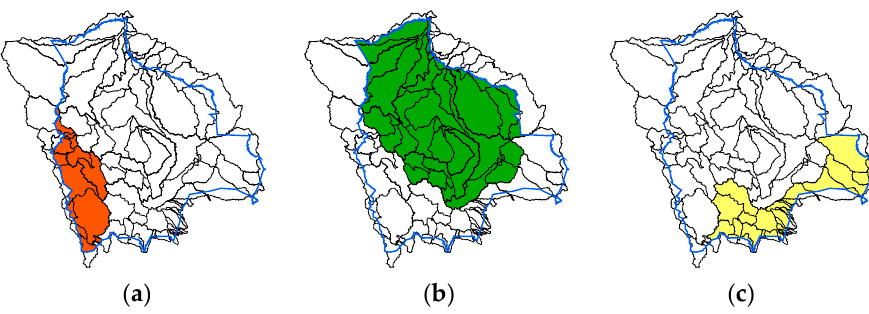
Figure 3. Basin delineation and areas represented in the model. ( a ) Altiplano; ( b ) Amazon; ( c ) La Plata.